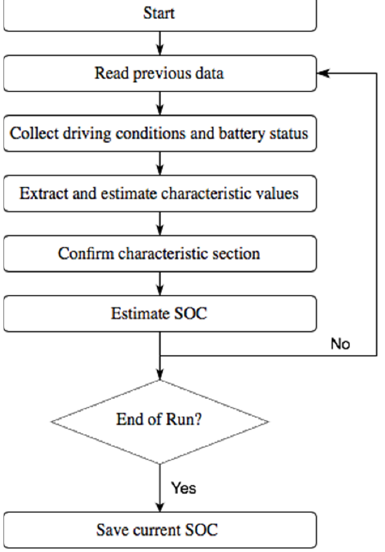
Figure 7. SOC partition ‐ estimation method based on electrochemical characteristics.